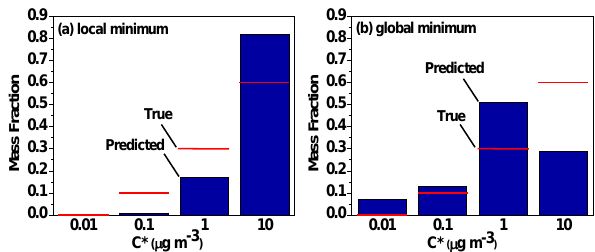
Figure 3. Estimated (bars) and true (red lines) volatility distribution for OA consisting of 10% C *=0.1 μg m -3 , 30% 1 μg m -3 , 60% 10 μg m -3 , ΔH vap =50 kJ mol -1 and a m =1, based on TD pseudo-data. (a) Solution corresponding to a local minimum of the objective function. The estimated vaporization enthalpy and accommodation coefficient are ΔH vap =38 kJ mol -1 and a m =0.9. (b) Solution for the global minimum. The estimated ΔH vap and a m are 68 kJ mol -1 and 0.84 respectively.